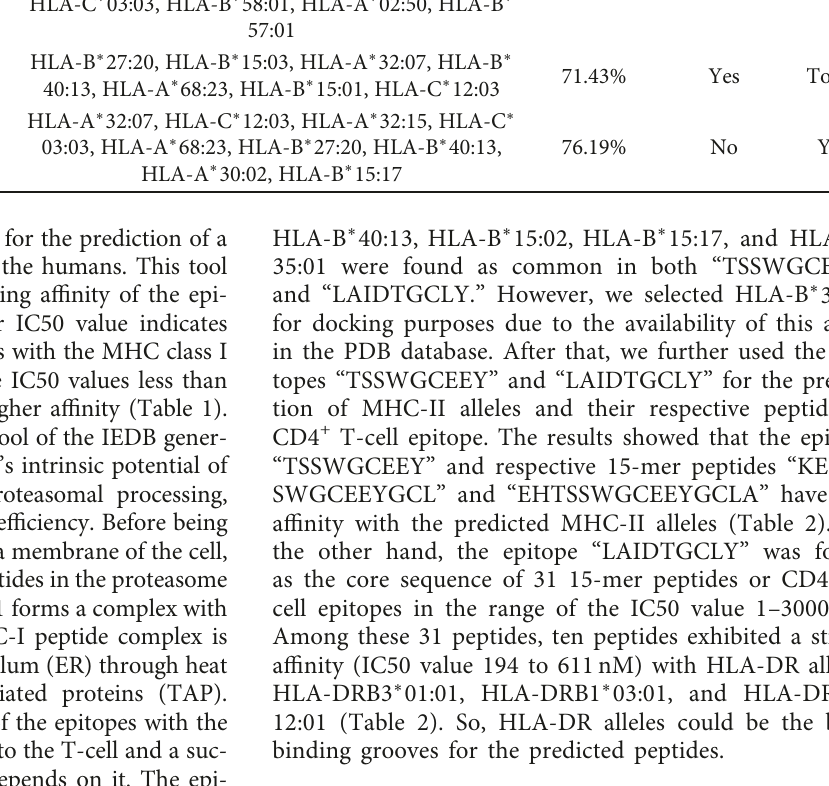
12:01 (Table 2). So, HLA-DR alleles could be the best- binding grooves for the predicted